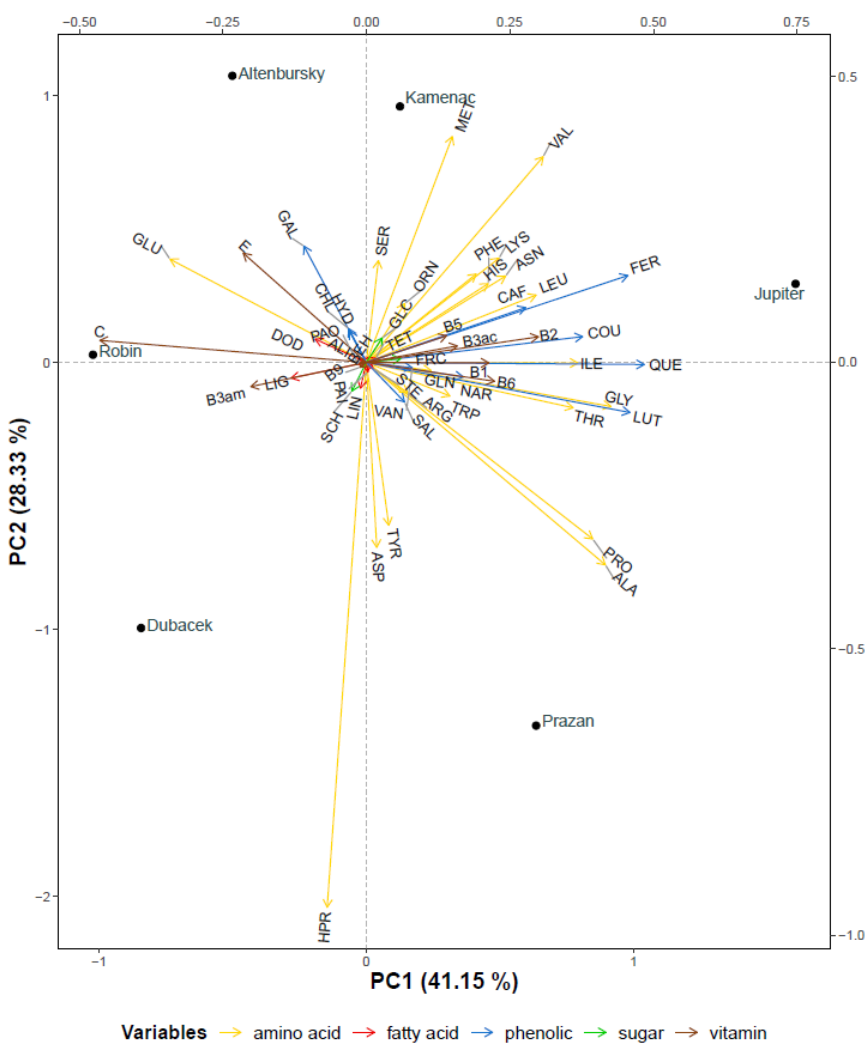
Figure 2. PCA biplot of the chemical composition of six lettuce varieties grown under control con- ditions.